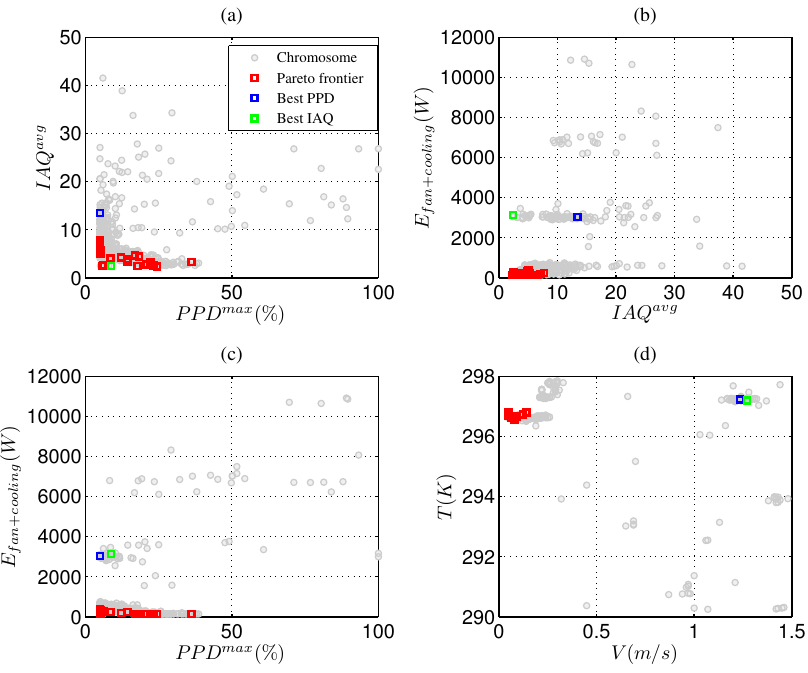
Figure 8. Bi-dimensional projections of the 3D objective space: ( a ) predicted percent dissatisfied (PPD)-indoor air quality (IAQ); ( b ) IAQ–Energy; ( c ) PPD–Energy; and ( d ) control variables